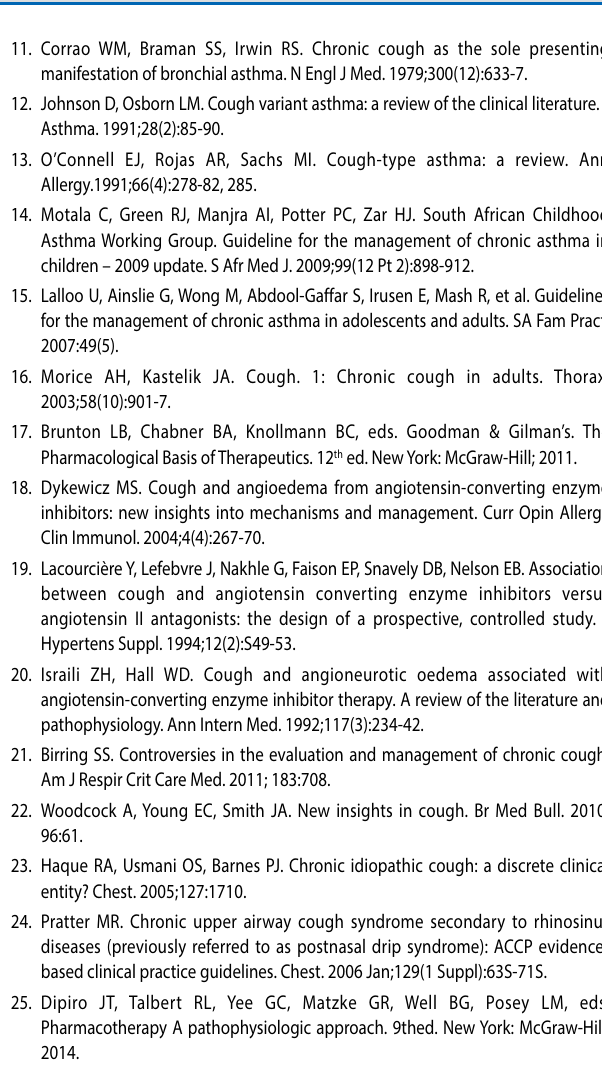
Pharmacological